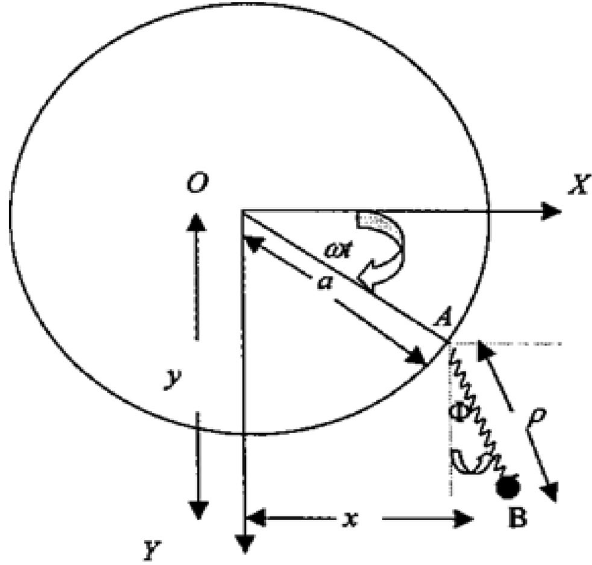
Figure 1. The pendulum motion on a sufficiently large